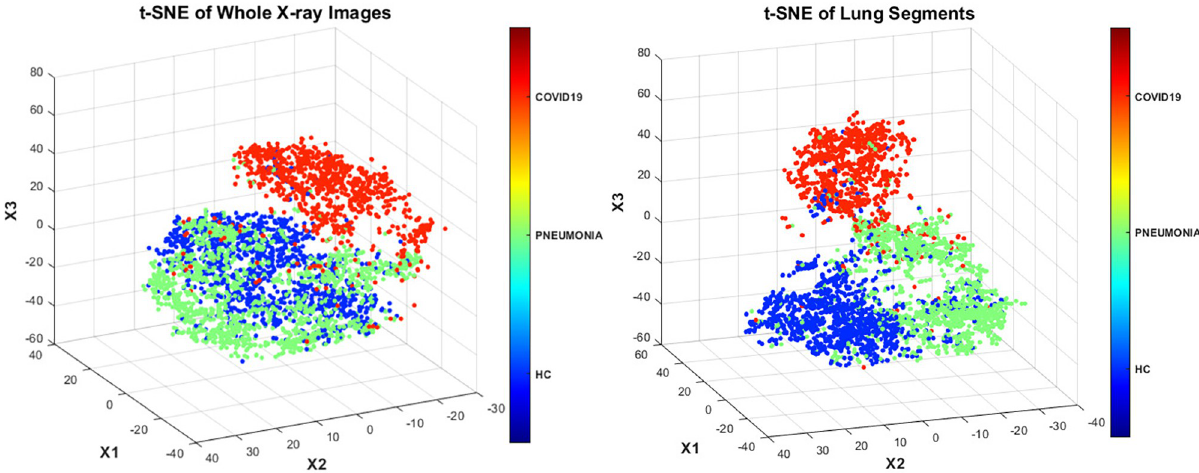
Fig 3. t-SNE dimensions of the class distributions using whole CXR images (left) and lung segments (right).